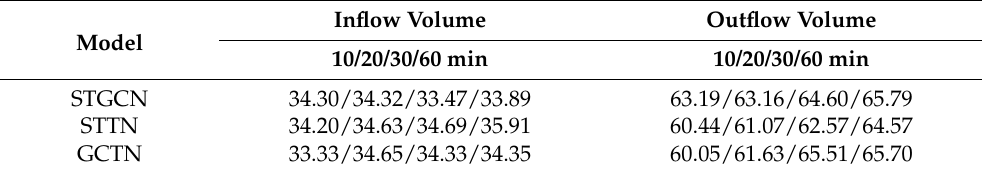
Figure 14. The time period that the passenger flow changes quickly in the People’s Square Station. ( a ) Inflow volume; ( b ) Outflow volume. Table 6. The prediction performance for the period when the passenger flow changes quickly at the whole